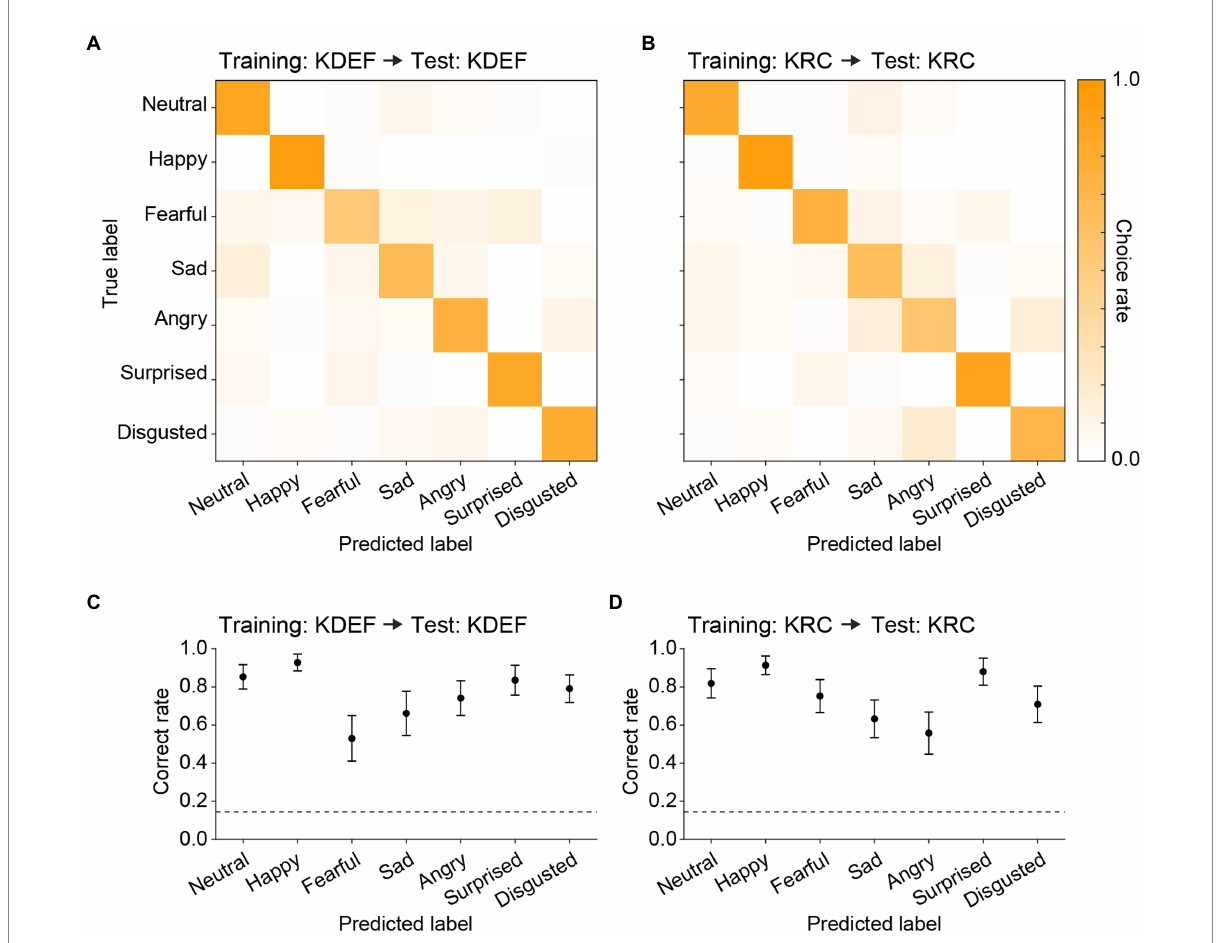
FIGURE 3 Classification performance of the CNNs in the database-matched conditions. The confusion matrices computed with the test datasets are shown for the KDEF-trained CNNs (A) and the KRC-trained CNNs (B) . The test and training datasets were derived from the same database. The mean choice rates averaged across 40 runs were coded by color (scale bar to the right). The correct rates of seven facial expressions are plotted for the KDEF-trained CNNs (C) and the KRC-trained CNNs (D) . The means and standard deviations across 40 runs are plotted. The dashed lines represent the chance level (1/7 =